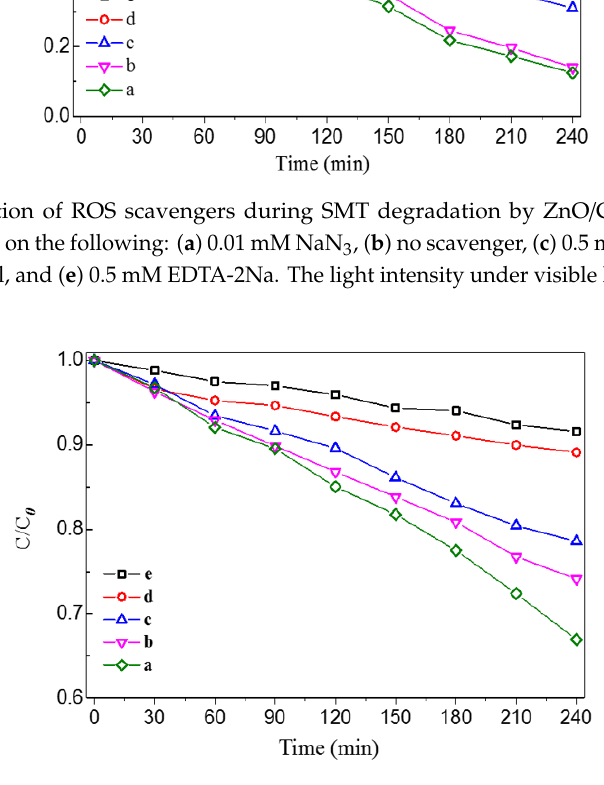
Figure 10. Intervention of ROS scavengers during SMT degradation by ZnO/Cu x = 1.25 O %) under visible light on the following: ( a ) 0.01 mM NaN 3 , ( b ) no scavenger, ( c ) 0.5 mM p-benzoquinone, ( d ) 0.5 mM EDTA-2Na, and ( e ) 0.01 mM methanol. Solution parameters: [catalyst] = 500 mg/L, [SMT] = 2.5 mg/L, initial pH 7.0. The light intensity under visible light irradiation was 38.9 mW/cm 2 .